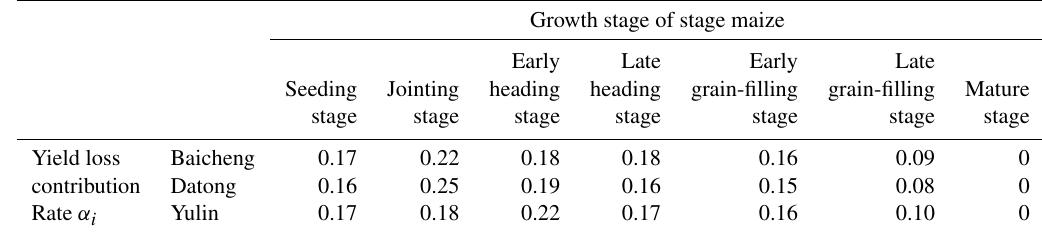
Table 2. Yield loss contribution rate α at Baicheng, Datong and Yulin.